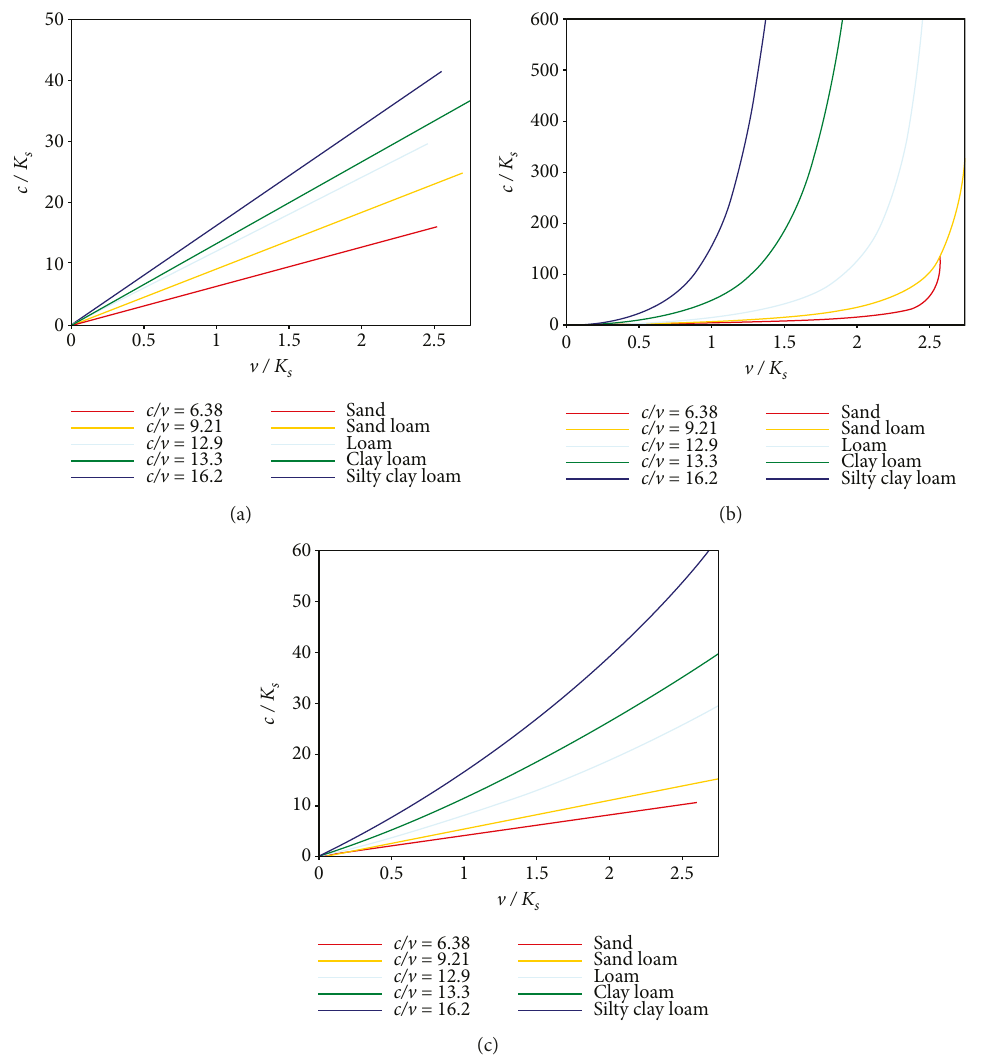
Figure 3: Relations between dimensionless celerity and dimensionless average pore water velocity for 5 typical soils under (a) the Brook- Corey model, (b) unmodi fi ed Mualem-van Genuchten model, and (c) modi fi ed Mualem-van Genuchten model. Table 3: Kinematic ratio under low saturation condition (e ff ective saturation Θ < 0 5 ). Soil types Sand Sandy loam Loam clay Brooks-Corey